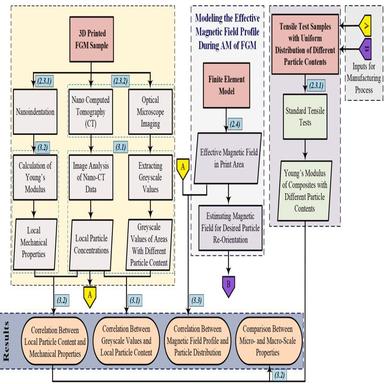
Flow diagram of the experimental and theoretical process followed in this study. The number next to each box indicates the section number in which the corresponding step is described.